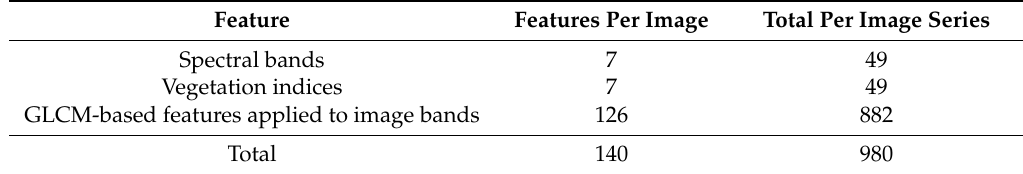
Table 2. Type and number of features extracted from a single multi-spectral WorldView-2 image, and from the time series of seven images. Gray Level Co-occurrence Matrix